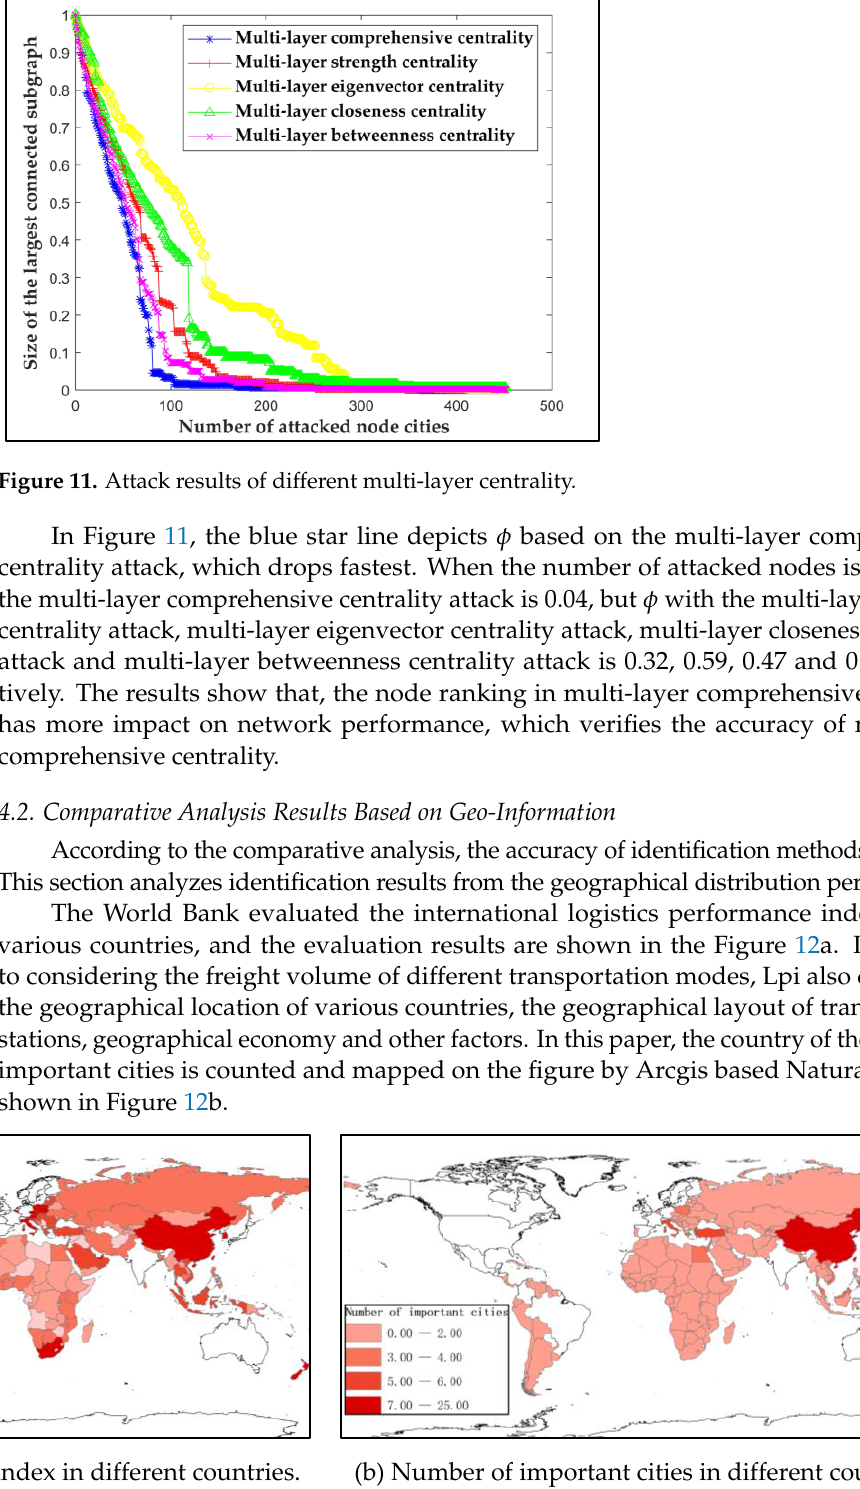
Figure 12. Logistics performance indexes and number of important cities in different countries.